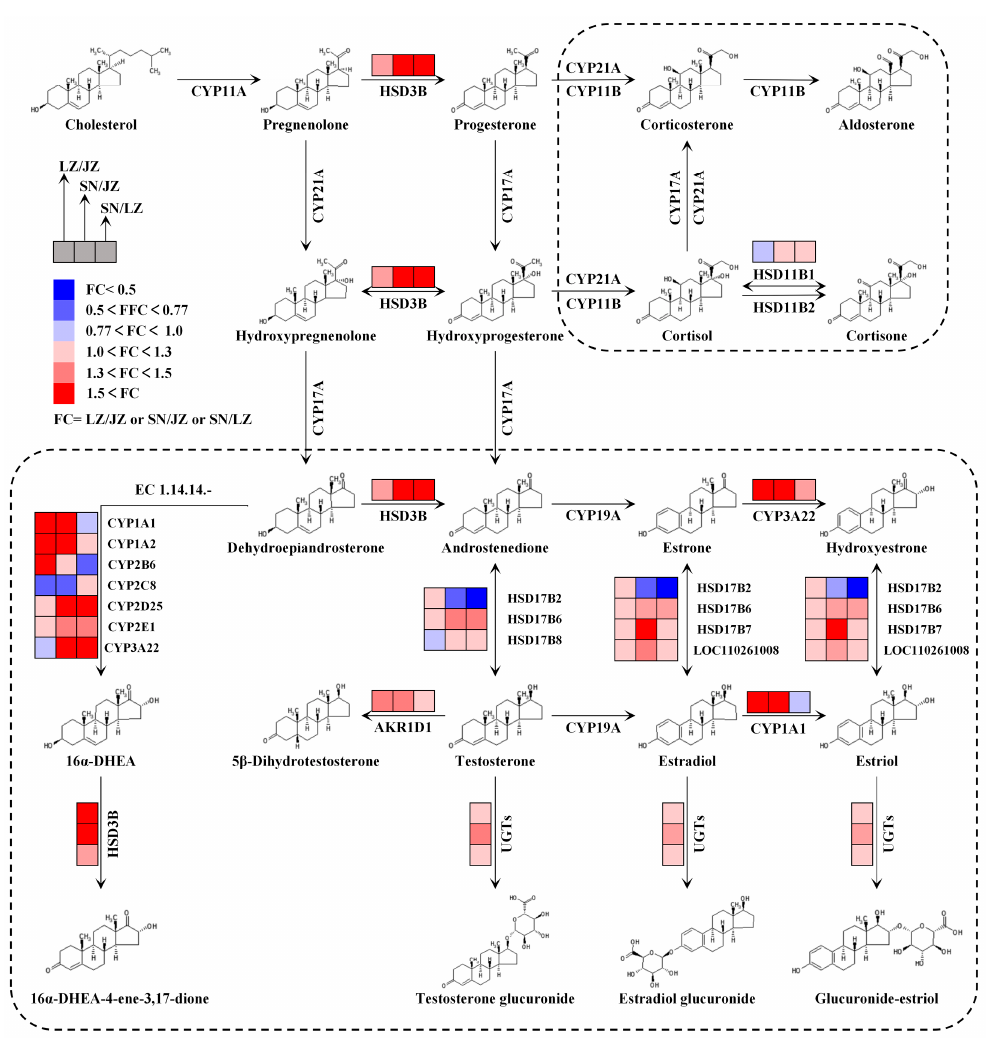
Figure 5. The protein expression in the liver of Tibetan pigs in the “steroid hormone biosynthesis” pathway.